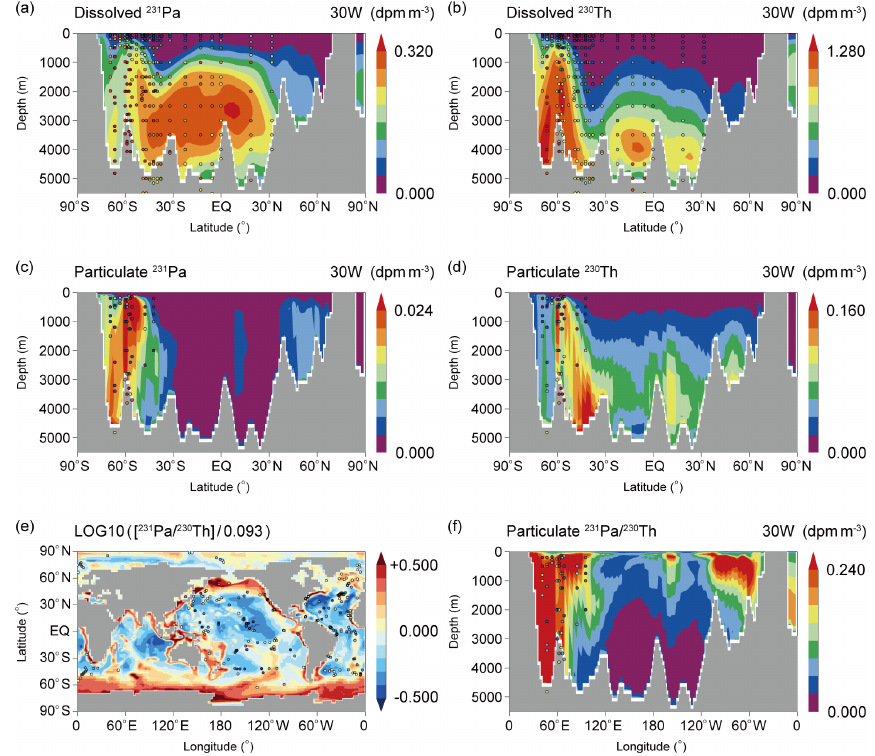
Figure 6. (a) Dissolved 231 Pa, (b) dissolved 230 Th, (c) particulate 231 Pa, and (d) particulate 230 Th along 30 ◦ W in the Atlantic Ocean in CTRL_EXP. (e) Sedimentary 231 Pa / 230 Th ratios normalized by the production ratio of 0.093 in CTRL_EXP. The colored circles represent observational data. Dissolved and particulate 231 Pa and 230 Th data are taken from the Atlantic GEOTRACES data (GA02 and GIPY05; Schlitzer et al., 2018). The data of sedimentary 231 Pa / 230 Th ratios are taken from the following references (Mangini and Sonntag, 1977; Müller and Mangini, 1980; Anderson et al., 1983; Shimmield et al., 1986; Schmitz et al., 1986; Yang et al., 1986; Shimmield and Price, 1988; Lao et al., 1992; François et al., 1993; Frank et al., 1994; Frank, 1996; Bradtmiller et al., 2014; Luo et al., 2010, and their supplemental